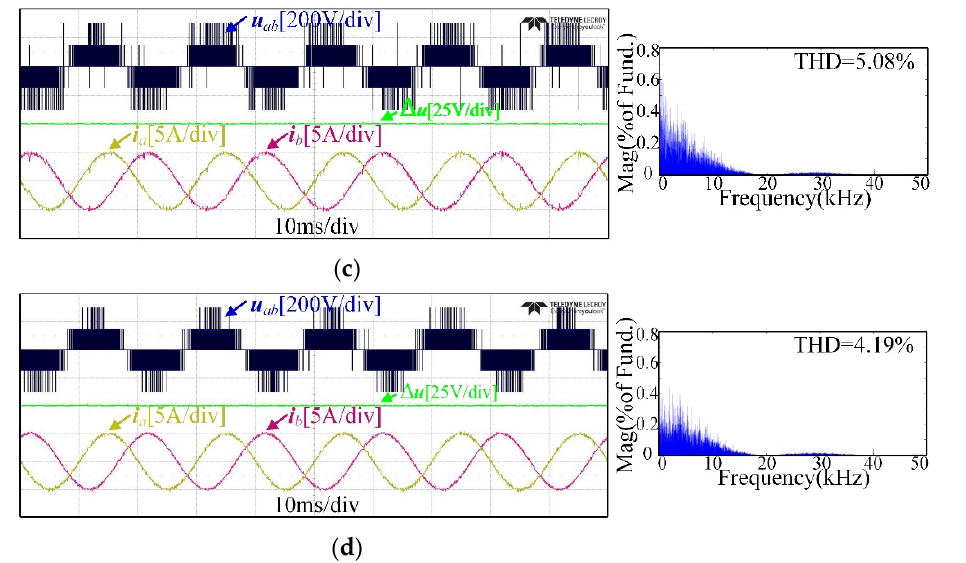
Figure 9. Experimental waveform comparisons ( i ref = 5A). ( a ) Waveforms under the conventional MPC scheme. ( b ) Waveforms under the conventional MFPC scheme in [20]. ( c ) Waveforms under the conventional MFPC scheme in [30]. ( d ) Waveforms under the proposed MFPC scheme.